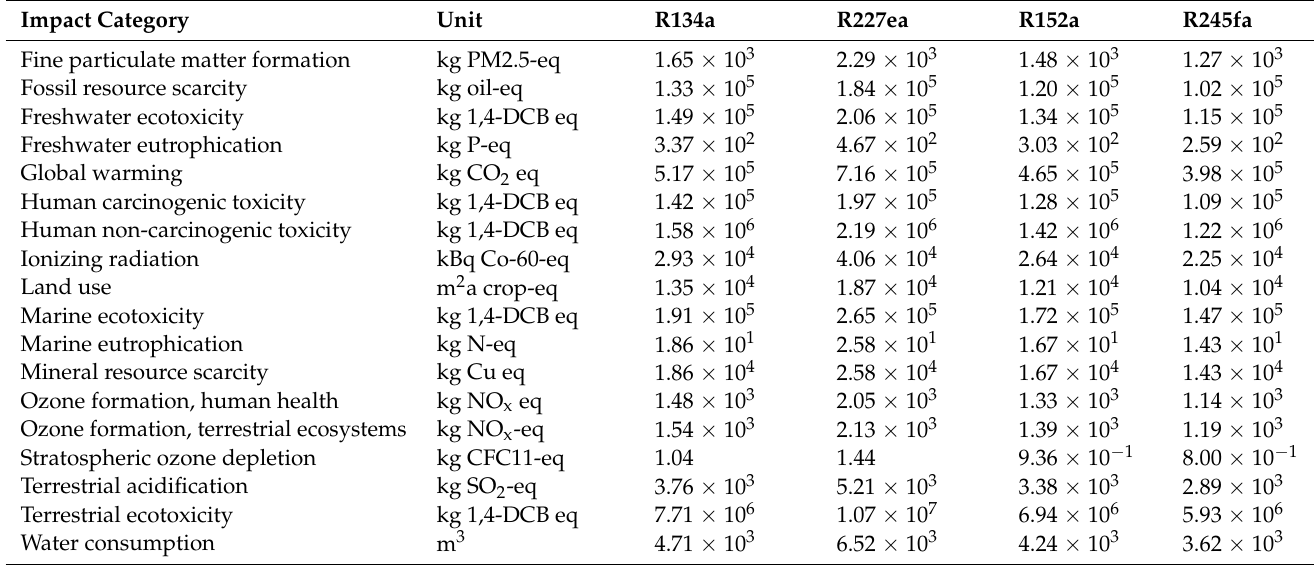
Table 10. The comparison between different types of ORC’s working fluids and their impacts on the environment based on ReCiPe 2016 v1.03 Midpoint (H) for the suggested design of the 246.02 kWh charging